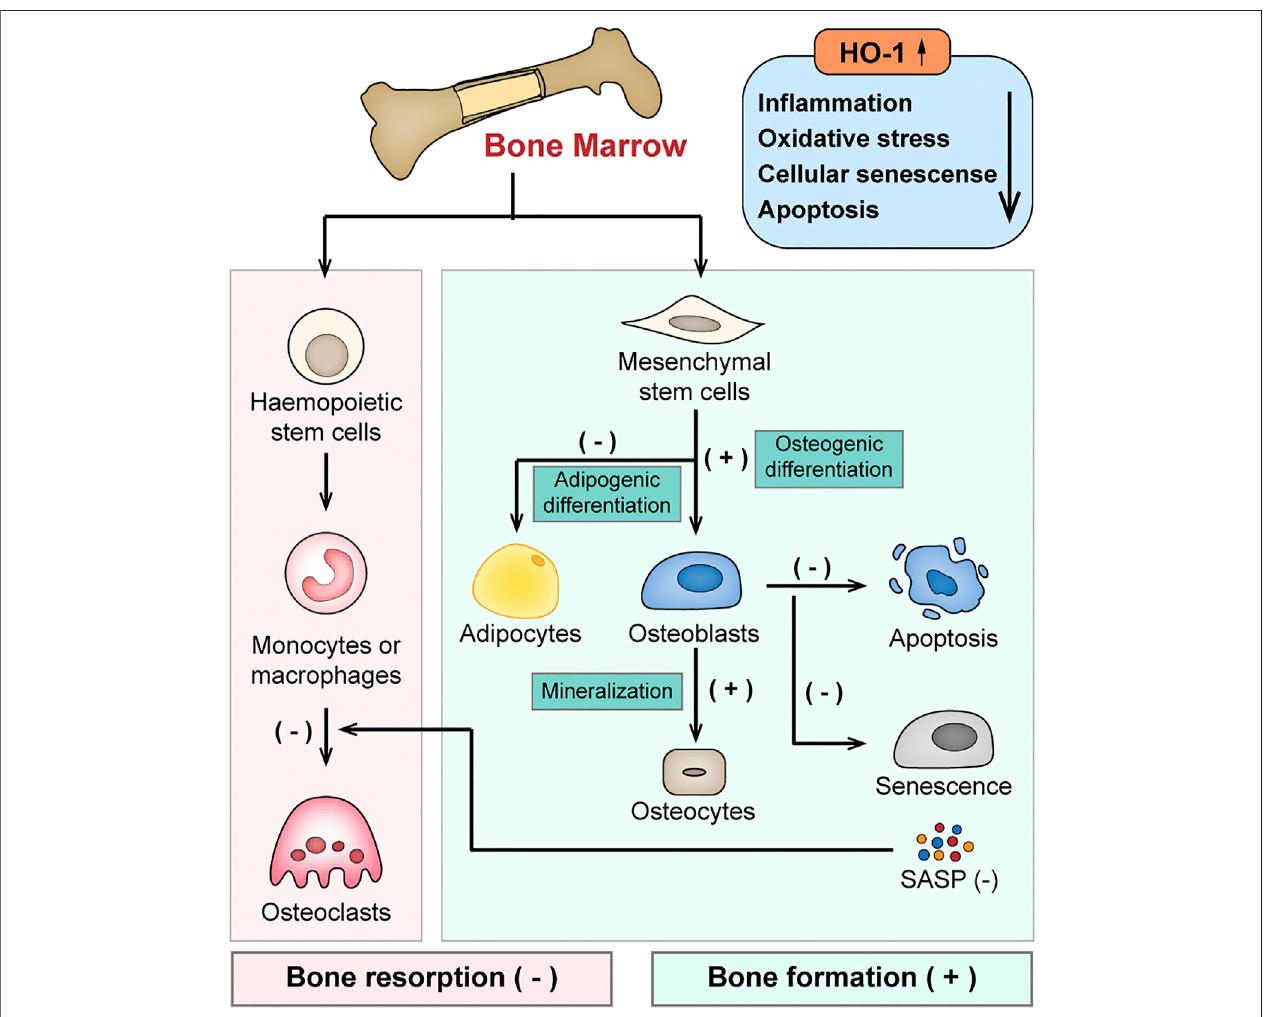
FIGURE3| SchematicdiagramoftheprotectiveeffectsofHO-1inboneremodeling.HO-1maintainsapositivenetbalanceofboneremodeling via dual-regulation of both osteoblasts and osteoclasts by alleviating in fl ammation, oxidative stress in the bone microenvironment. HO-1 regulates the differentiation of bone mesenchymal stem cells (BMSCs),enhances osteoblast function and inhibits the apoptosis and senescence ofosteoblasts. Italso negatively regulates the differentiation or function of osteoclasts.